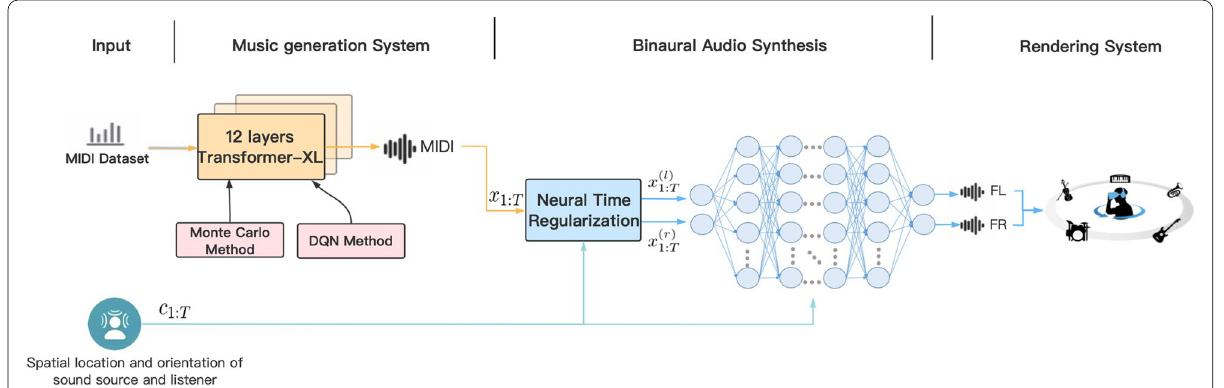
Fig. 1 The MetaMGC network